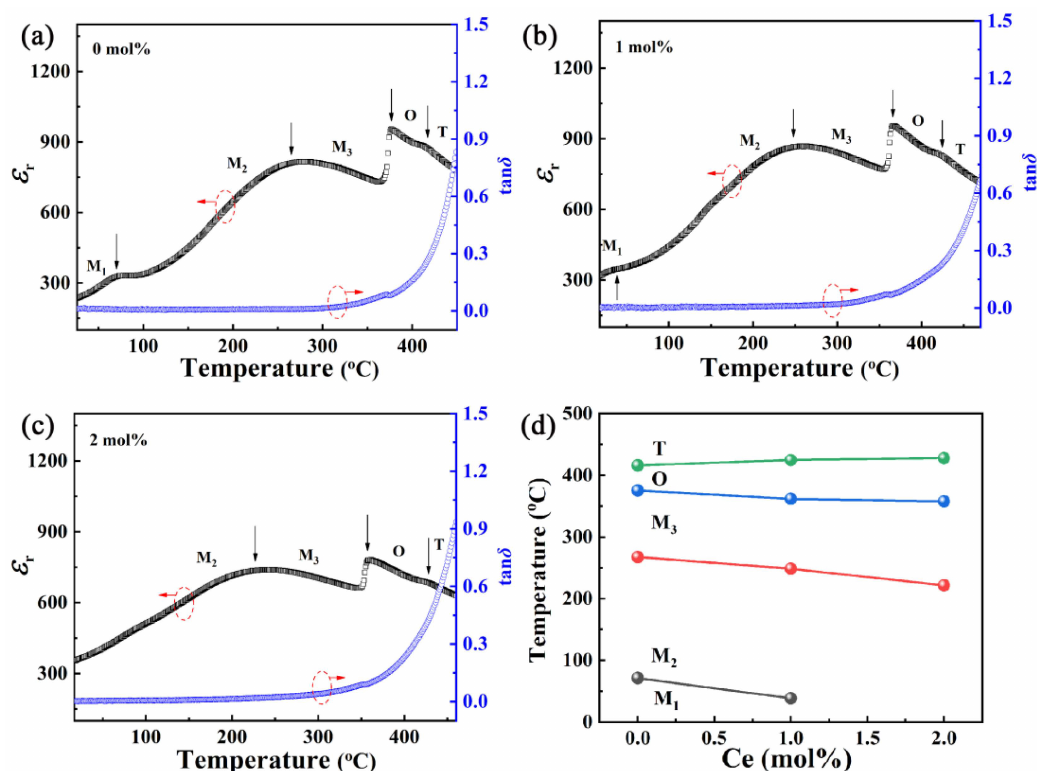
Figure 5. Temperature dependence of the dielectric constant ( ε r ) and dielectric loss (tan δ ) of ( a )ANCe0, ( b ) ANCe1, and ( c ) ANCe2 ceramics. ( d ) Phase diagram of the ANCe x ceramics. (The red circles and arrows point to the axes corresponding to the data and black arrows point to the phase transi- tion